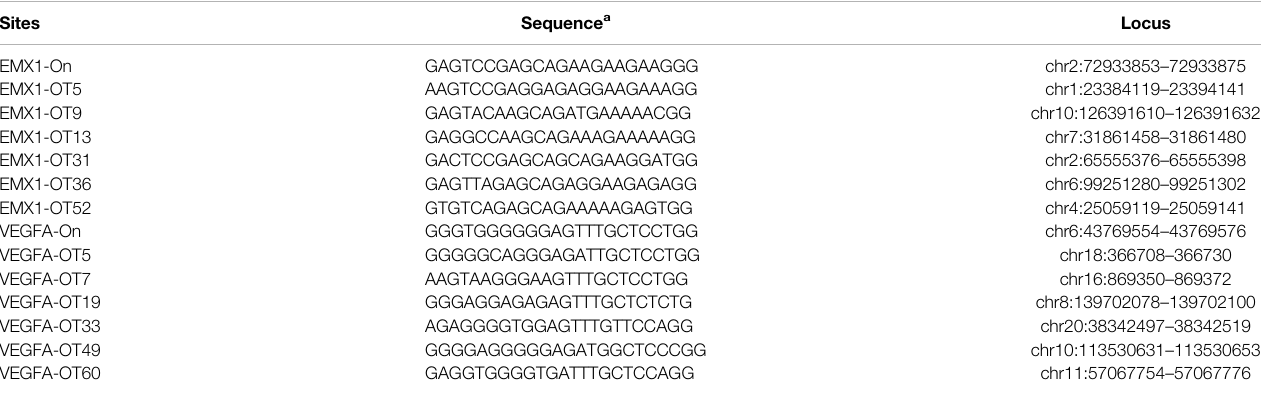
TABLE 1 | Off-target sites of EMX1 and VEGFA site 1 in this